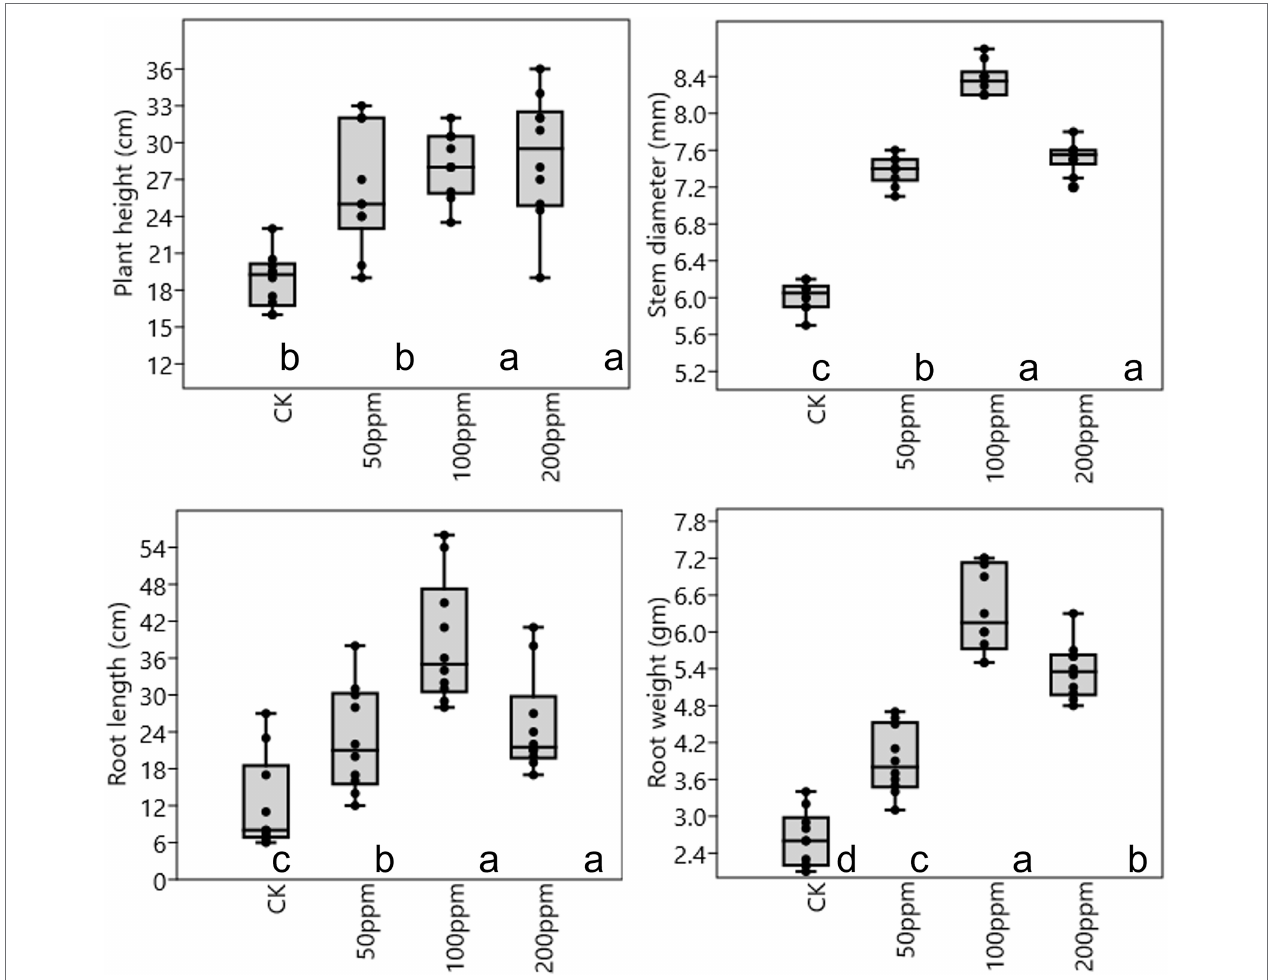
FIGURE 2 | Plant physiological parameter in response to different concentrations of IBA. Bars with different letters indicate significant differences at the p < 0.05 according to